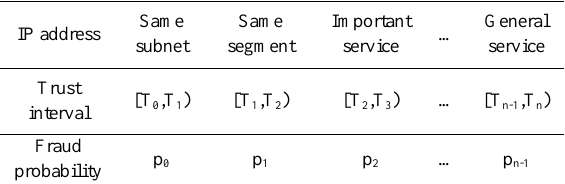
Table 2. Trust evaluation table for the IP factor